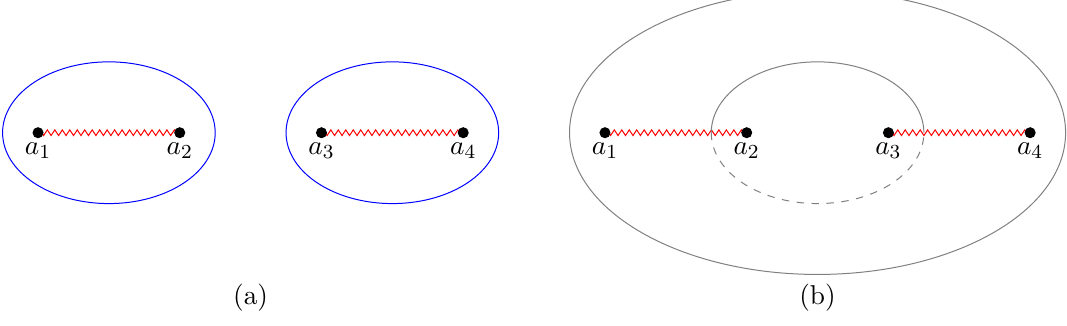
Figure 6 . The choices of cycles around which we can impose trivial monodromy to construct the dual handlebody. (a) trivial monodromy around the two cycles that circle the branch cut, denoted by C , which corresponds to the disconnected RT surface in the limit n → 1 ; (b) trivial monodromy d around the cycle that circles around both branch cuts and the cycle that passes through the branch cuts and laces through all the n sheets, denoted by C , which corresponds to the connected RT c surface in the limit n → 1